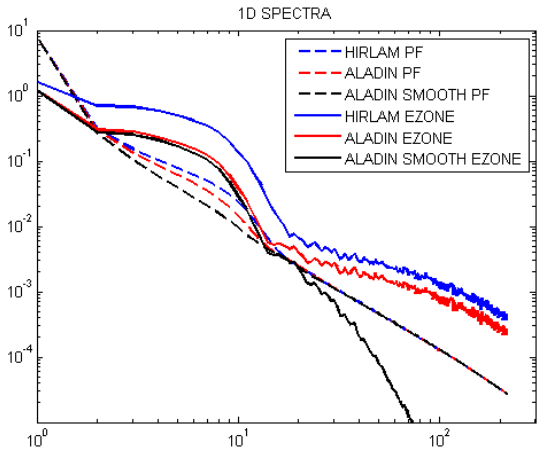
Figure 11. Average one-dimensional spectra only in the extension zone (EZONE, solid lines) and only in the physical field (PF, dashed lines) for HIRLAM, ALADIN and ALADIN SMOOTH